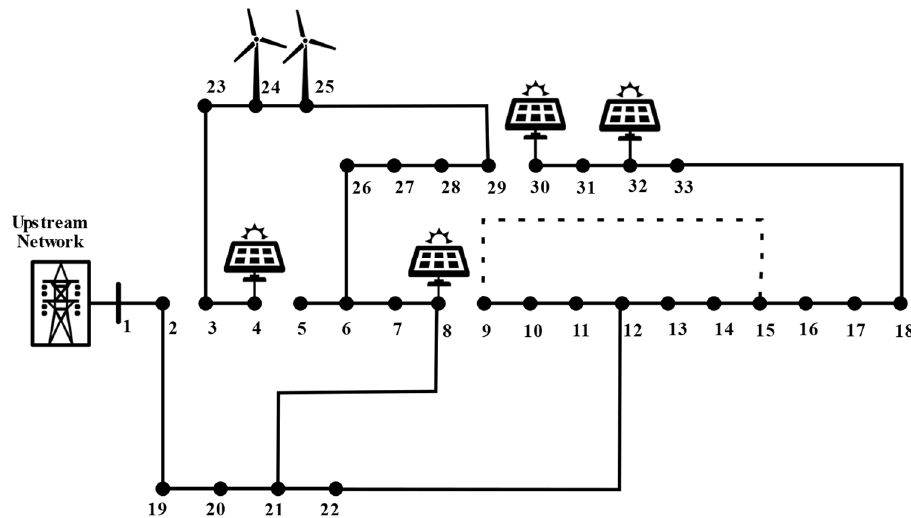
Figure 7. Restoration results for Scheme I.